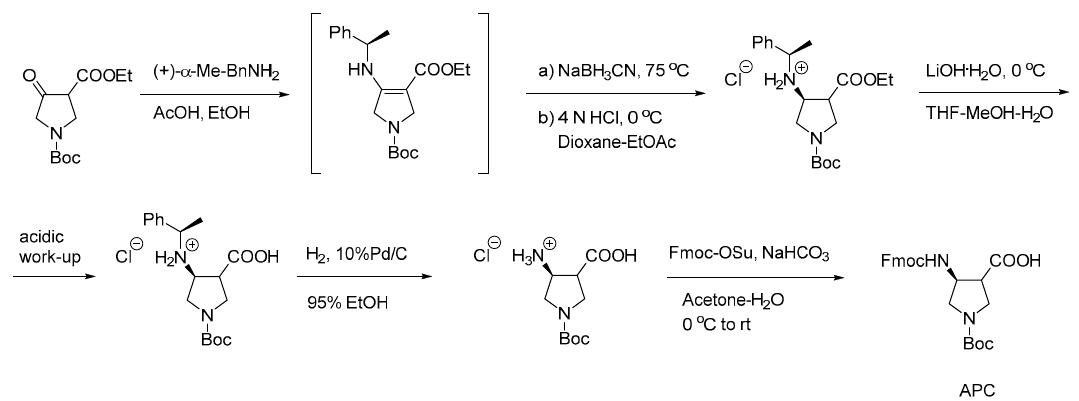
Scheme 13. Synthesis of an Fmoc-protected cyclic β 3 -amino acid building block